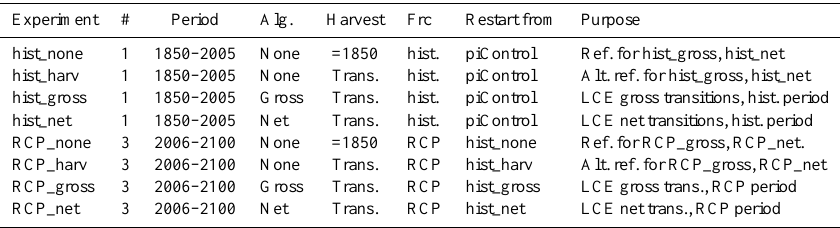
Table 1. Performed experiments. RCP-forced experiments include runs for RCP2.6, RCP4.5 and RCP8.5. Experiments with no LULCC have their distribution of agricultural land fixed at the time where also the harvest from the natural vegetation is fixed. The hist_none experiments are restarted from the coupled piControl experiment so that hist_gross reproduces the “r1” ensemble member. “#”: number of scenarios for this setup, “Alg”: LULCC algorithm, “Trans.”: transient, “Frc.”: forcing, “hist.”: